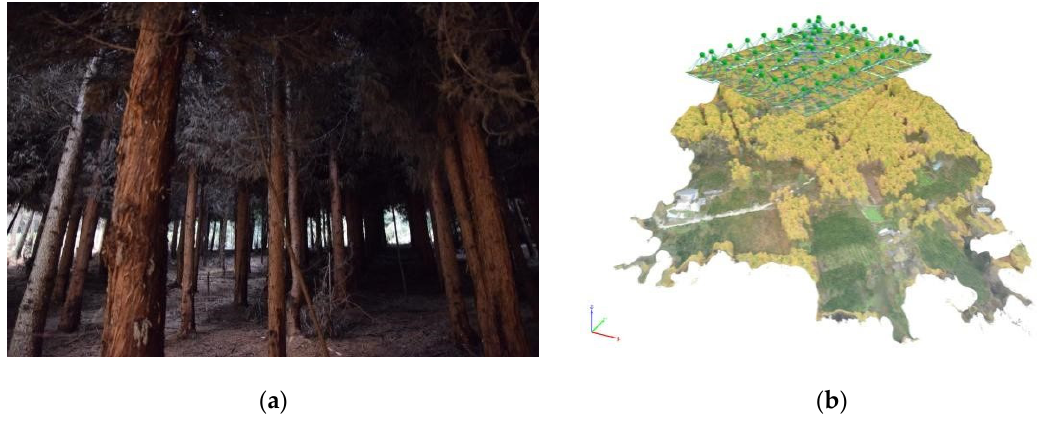
Figure 4. Field sample site photo ( a ) and 3D point cloud map ( b ).